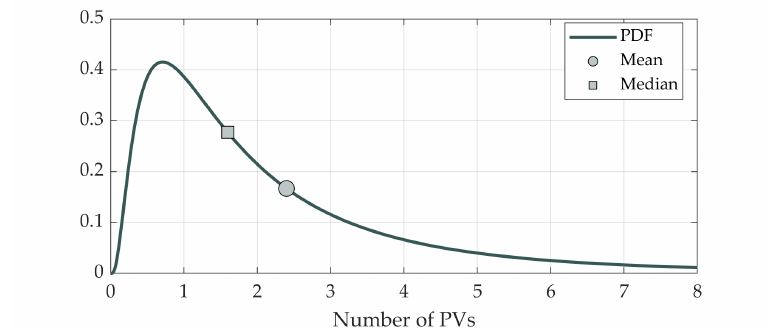
Figure 3. Lognormal distribution used for sampling the number of PVs in rural